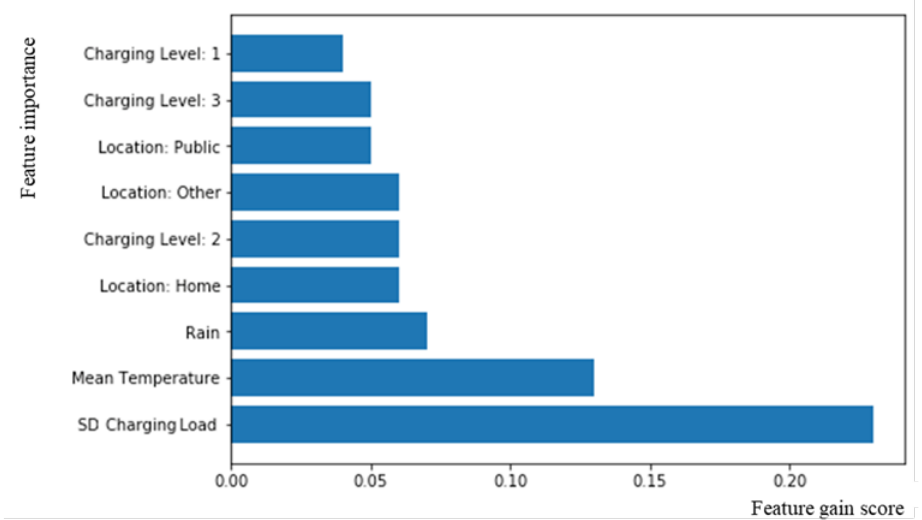
Figure 5. XGB feature importance.